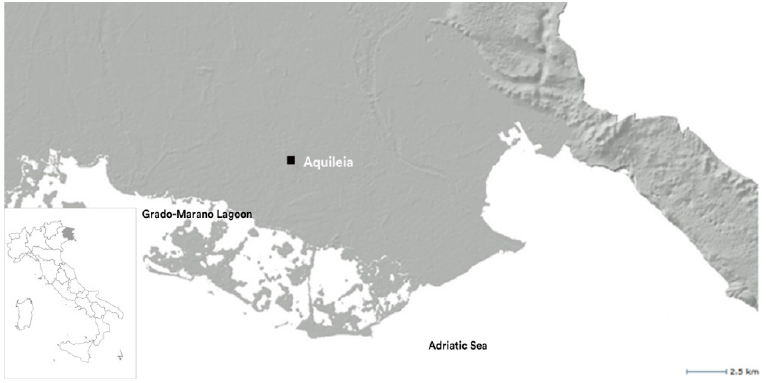
Figure 1. The case study area: Aquileia, located in NE Italy and its neighboring